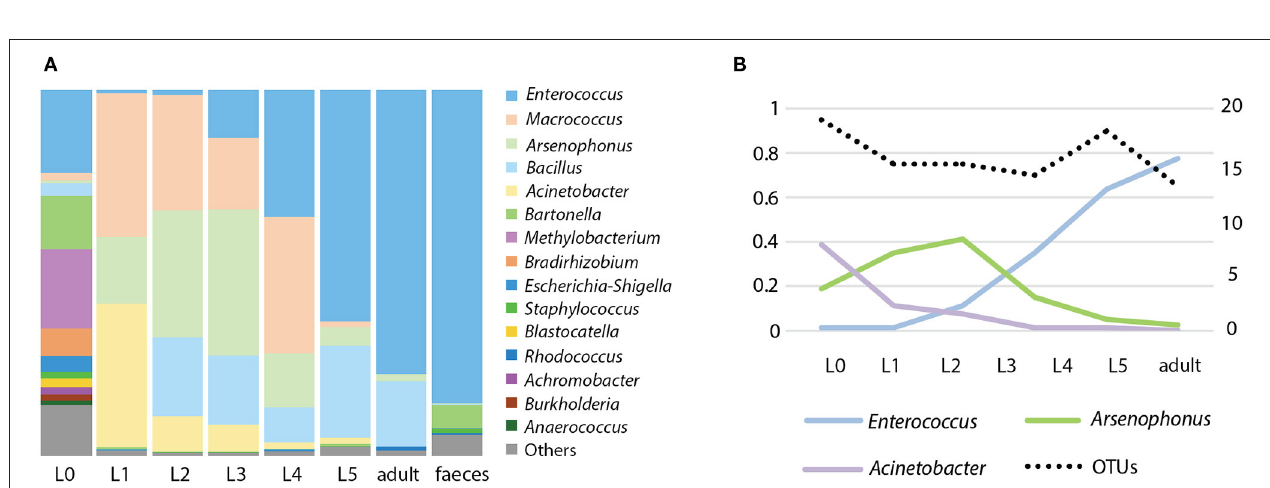
FIGURE 1 | NMDS visualization of the ontogenetic shift of R. prolixus microbiome. F stands for feces, L0 for eggs, L1–L5 for nymphal instars. (A) Microbiome shift along the different developmental stages of R. prolixus . (B) NMDS including microbiome richness and 95% confident ellipses for each developmental stage. The ellipses were calculated with the stat_ellipse function of ggplot2 package.